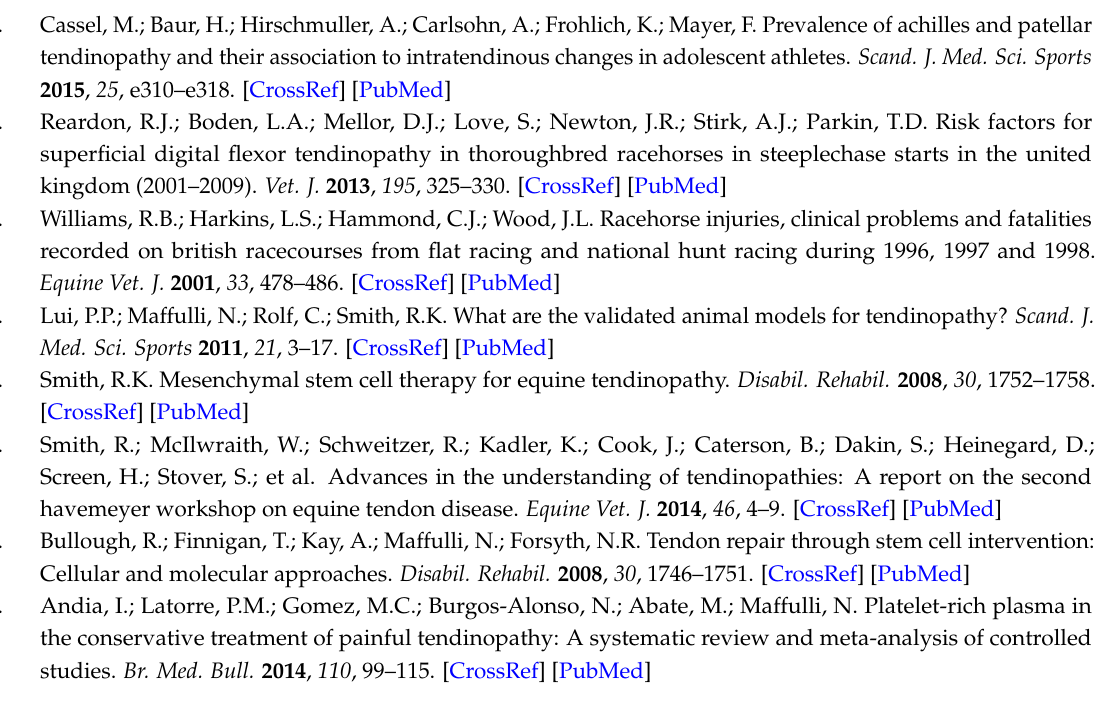
Figure S1: Representative pictures of haematoxylin and eosin stained tendon tissue sections from the three horses used for RNA-seq experiments confirming good quality, non-degenerated tissue, Table S1: Analysis of RNA Seq Data, Table S2: Table showing oligonucleotides used in qPCR reactions. Acknowledgments: The authors would like to thank the Functional Genomics Center Zurich; Catharine Aquino and Lennart Opitz, for help with data analysis and RNA sequencing. This study was financially supported by a CABMM Start-up